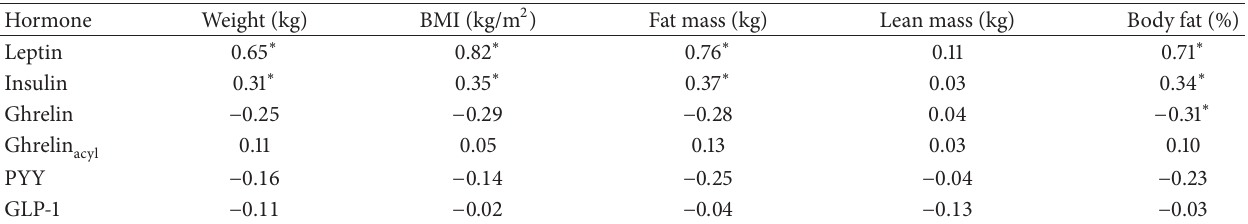
Table 3: Association between body weight and body composition and fasting hormone concentrations in 24 postpartum lactating and 20 never-pregnant